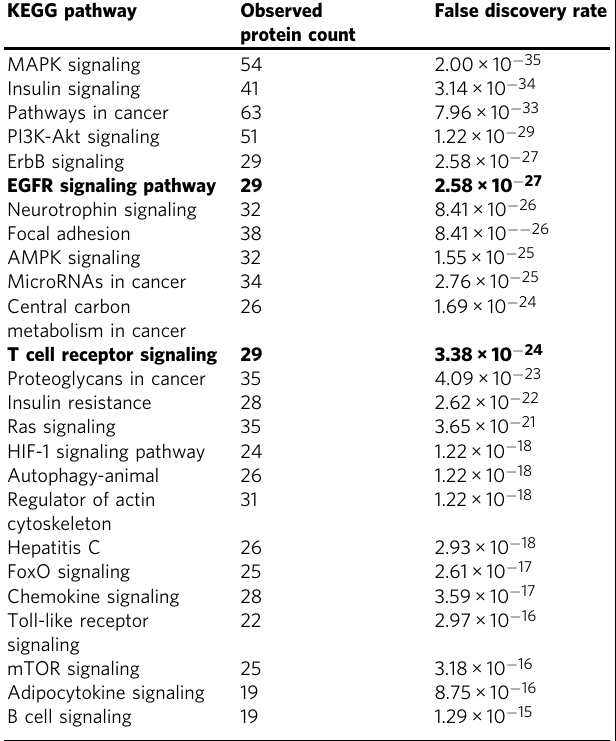
Table 1 Top 25 KEGG pathways in reserpine-treated explants compared to non-treated